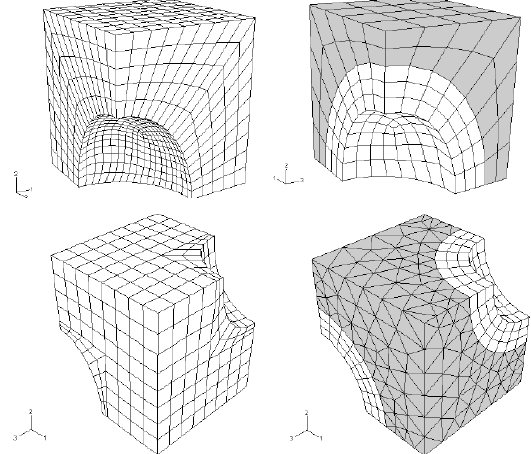
Figura 8: Microcelle unitarie ad una e due cavità per la modellazione della ghisa nodulare.